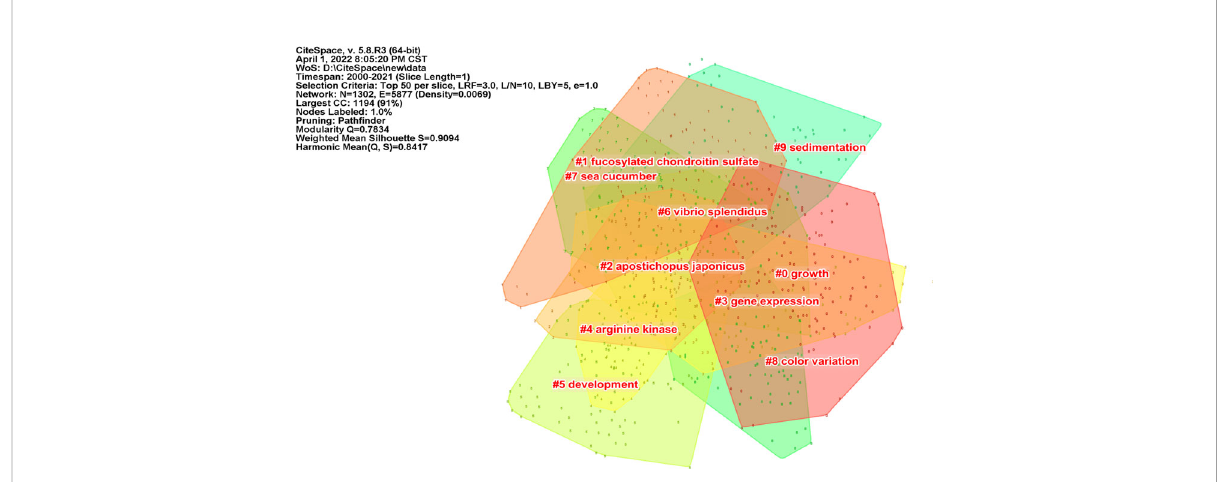
FIGURE 4 A network clustering map of keywords in the fi eld of Apostichopus japonicus from 2000 to